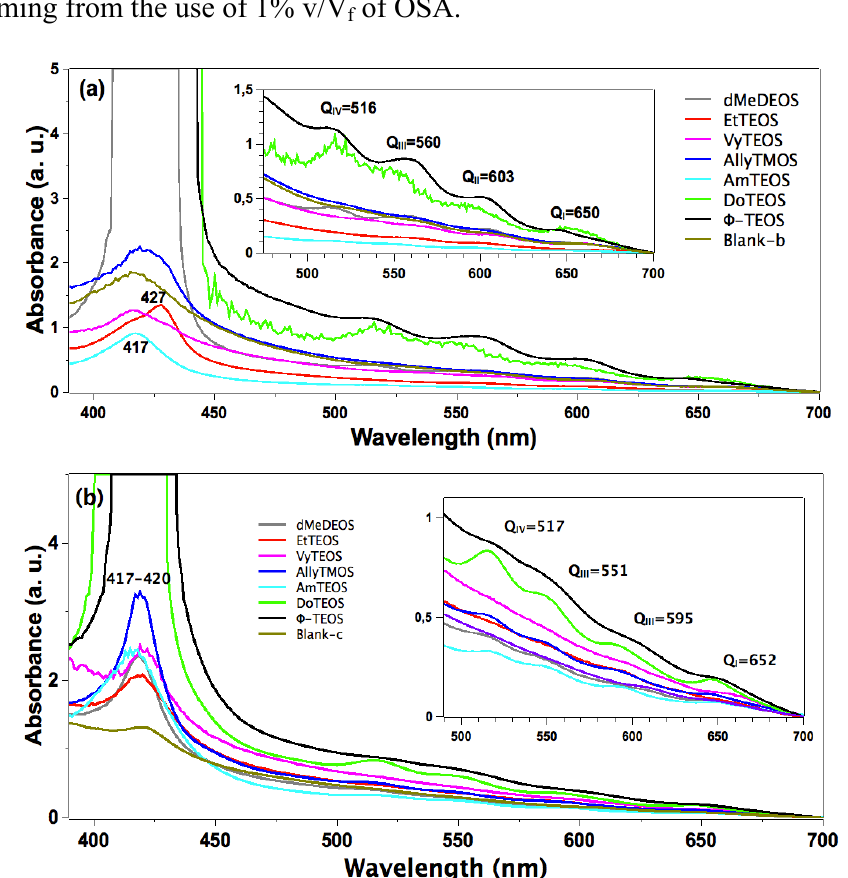
Figure 3. Absorption spectra of the H the use of ( a ) APTES or ( b ) NAEPTES, to the pore walls of silica modified with organic groups coming from the use of 1% v/V